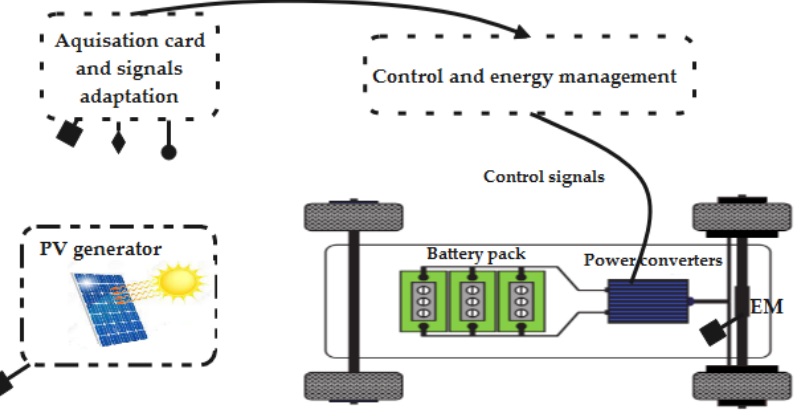
Figure 1. A description of the studied system. 2.1. Modeling of Triple-Junction Solar Cell InGap/InGaAs/Ge The triple-junction InGap/InGaAs/Ge solar cell includes three sub-cells with different wavelengths in series. Electrical representation, by adapting the decreased energy band-gap from the top to the bottom structure, is given in Figure 2.